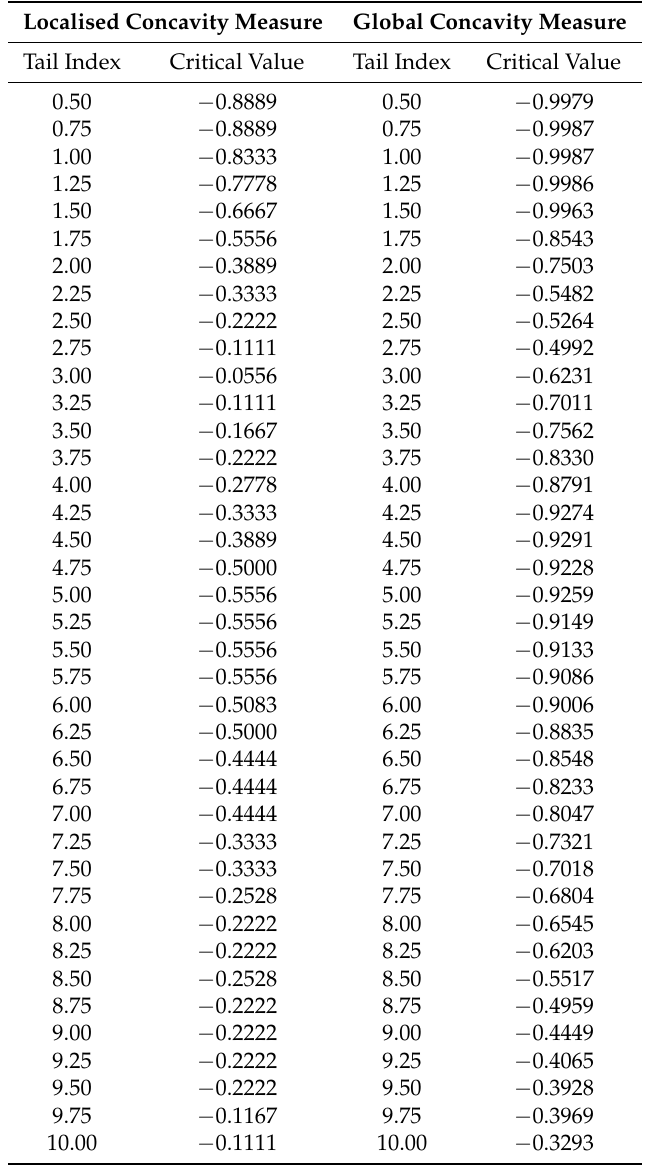
Table A1. Look-up tables for multifractality hypothesis